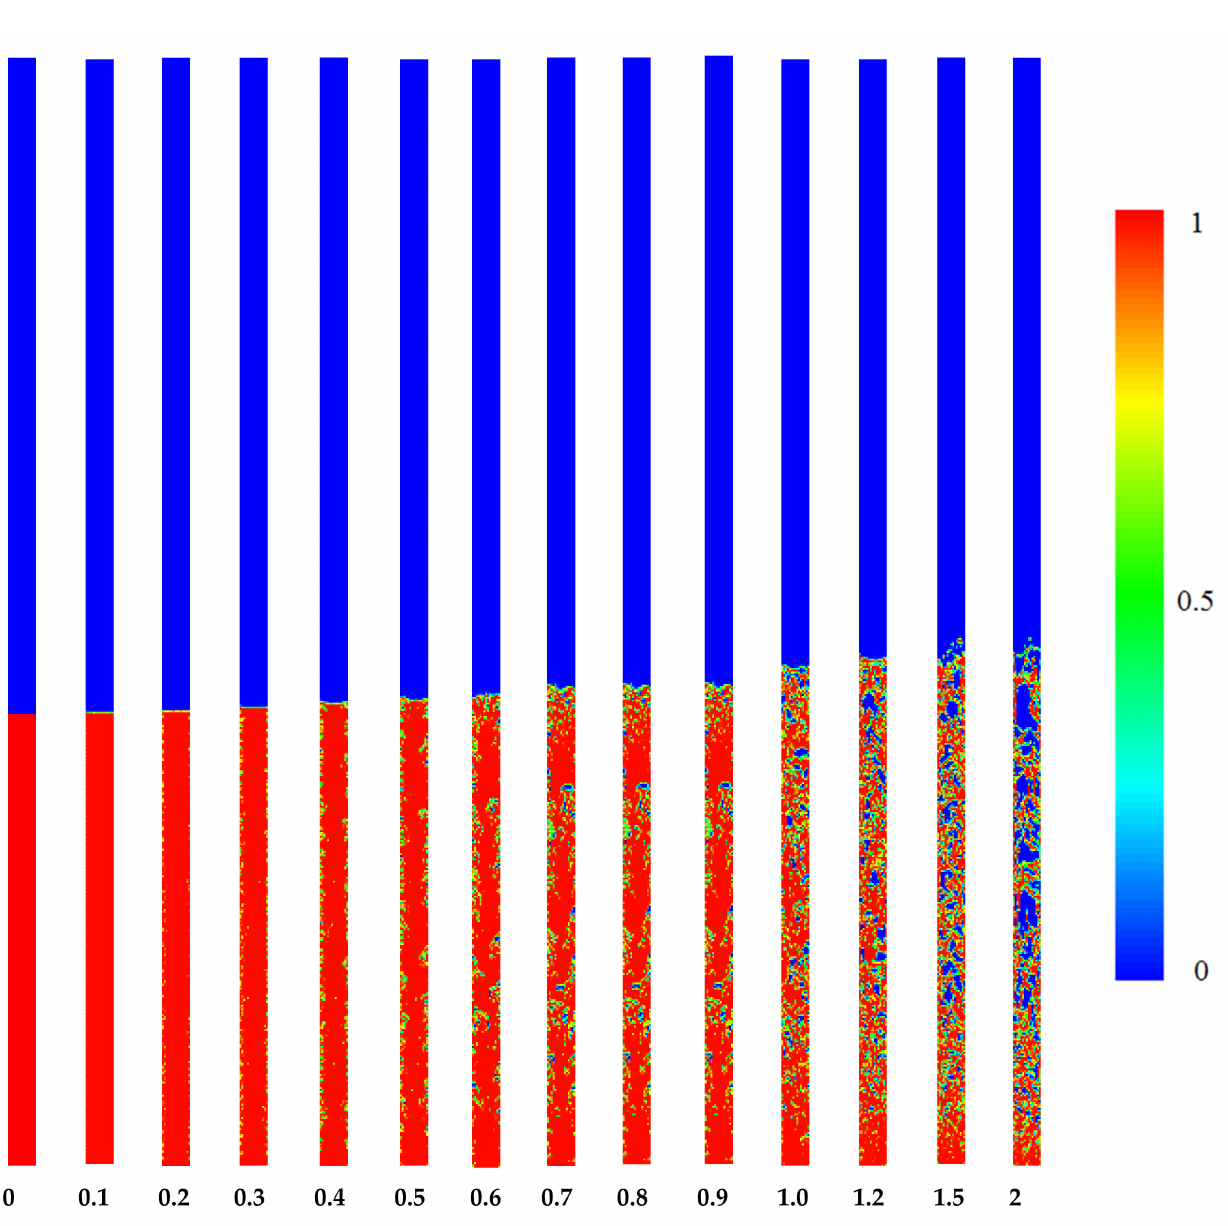
Figure 7. Contours of volume fraction in entire parts of TPCT at different times for FR = 90%. To obtain a better comparison between the formation and growth of bubbles in dif- ferent filling ratios, the contour of the liquid volume fraction in the evaporator part, for two times of 0.7 and 2 s, are presented in Figure 8. Relatively tiny bubbles are observed for the filling ratio of 50%, while more and more giant bubbles are generated at higher filling ratios. When the FR is equal to 90%, the interconnectedness of the bubbles in the areas near the border of the adiabatic part can also confirm the higher thermal resistance of the TPCT at higher filling